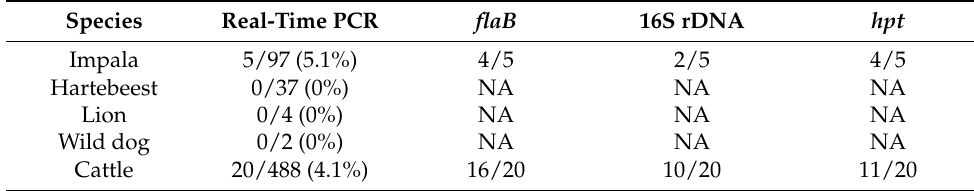
Table 2. Results of each PCR